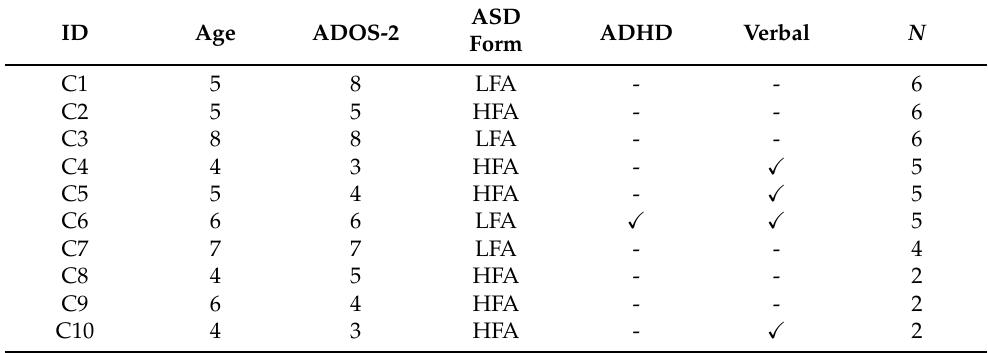
Table 1. Children’s demographics and other characteristics (ADOS-2 score, ASD form, presence of co-occurring ADHD, verbal, or non-verbal), and the number of attended